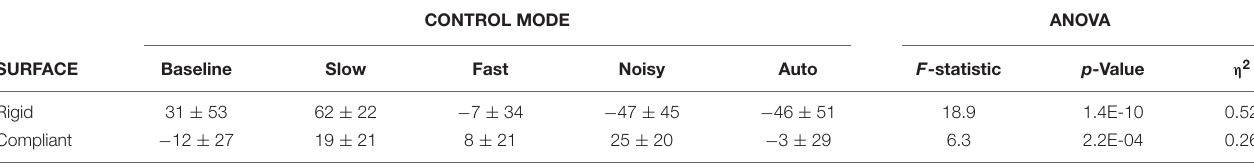
TABLE 3A | Mean implicit agency (time-interval underestimation, msec ) across control modes on rigid and compliant surfaces.